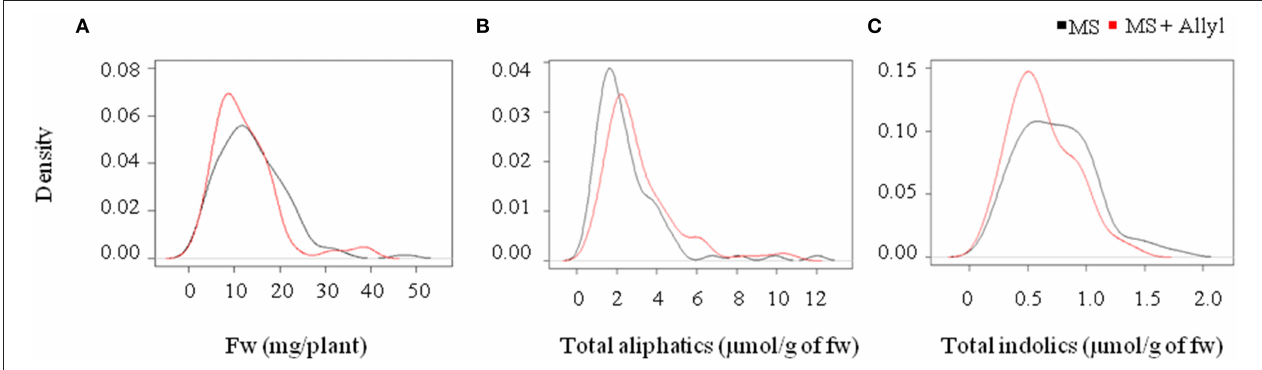
FIGURE 1 | Natural variation in Arabidopsis biomass and GSL accumulation in response to exogenous allyl GSL. (A) Kernel density plots showing the distribution of fw (mg/plant), (B) total aliphatic GSLs, and (C) total indolic GSLs ( µ mol/g of fw) from 96 natural Arabidopsis accessions grown in MS (black line) and MS + Allyl (red